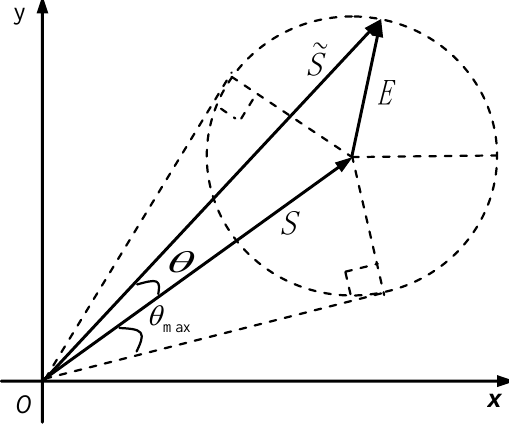
Figure 3. Geometric relation between 𝑺̃ , S , and E on the complex plane.